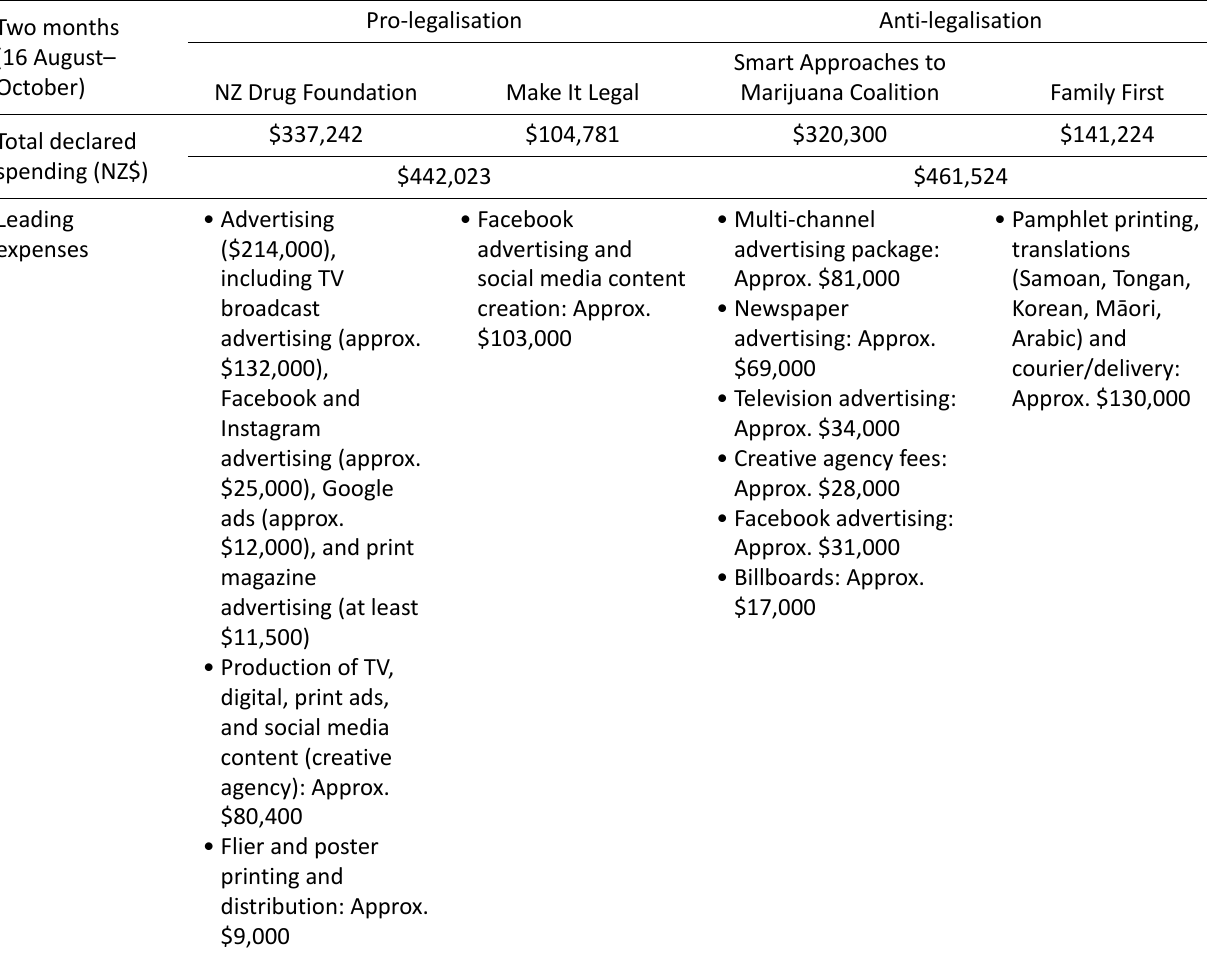
Table 1. Referendum campaign spending by the top four campaigners.